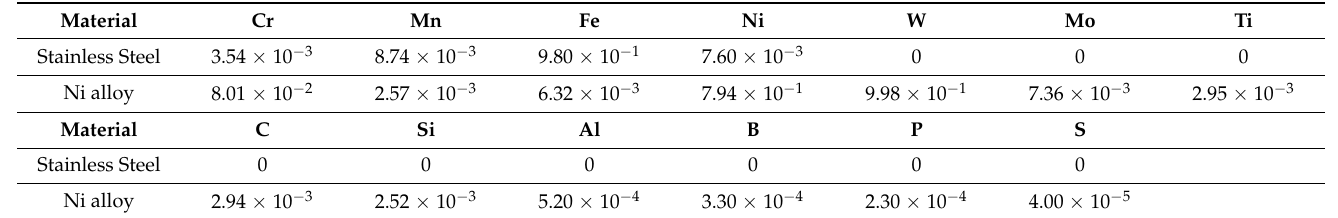
Table 2. Composition of stainless steel and Ni-based alloy applied in simulation (atom fraction).